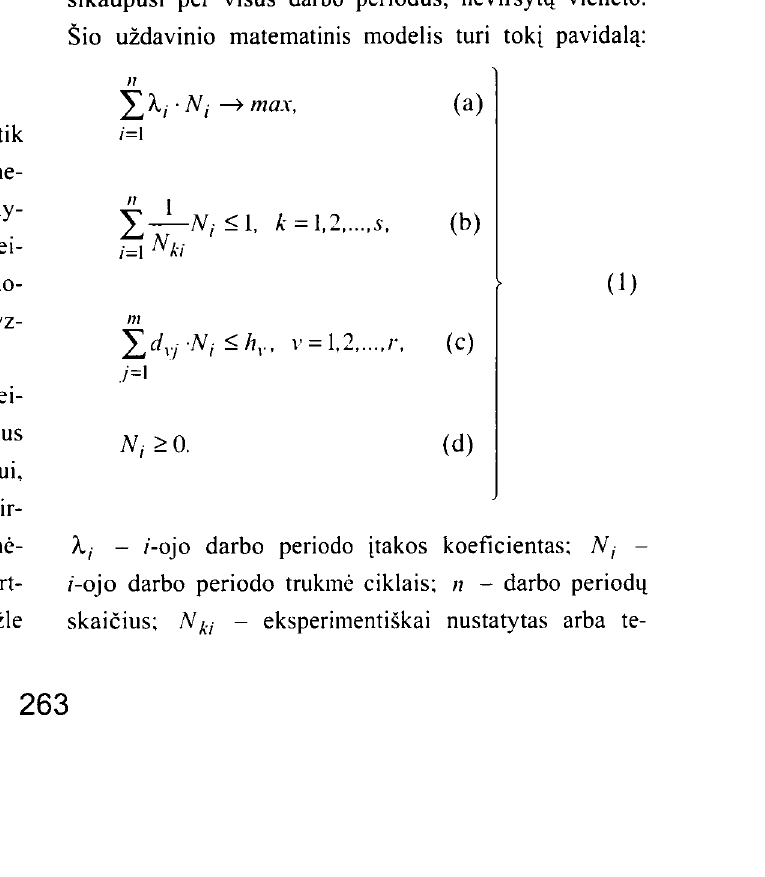
Fig 1. Fatigue curve of turns in the thread joint Smeiges VIJ4 nuovargio kreive priklauso ne tik nuo jungties geometrini4 matmen4 ir medziagos